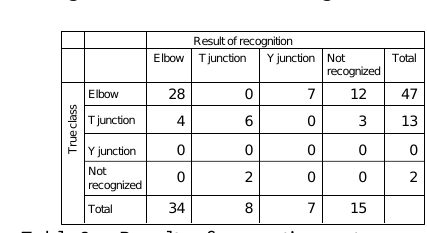
Table.2 Results of connecting parts